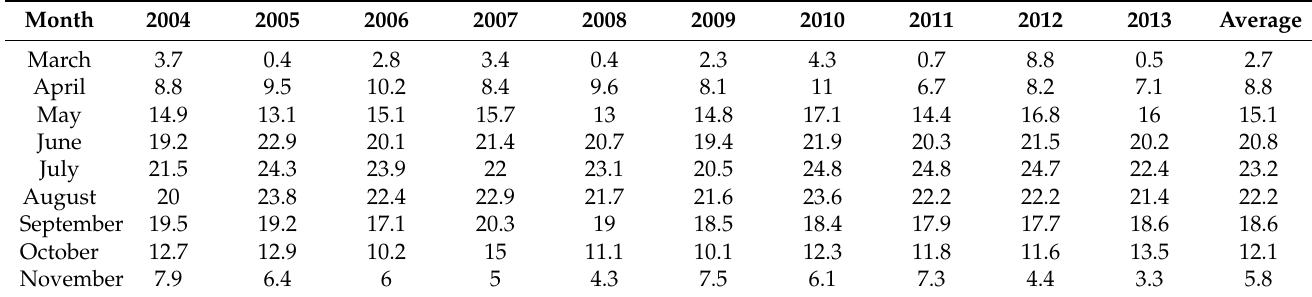
Table 2. Growing seasonal monthly mean temperature ( ◦ C) on the experimental site, Woodslee, ON, Canada, from 2004 to 2013.